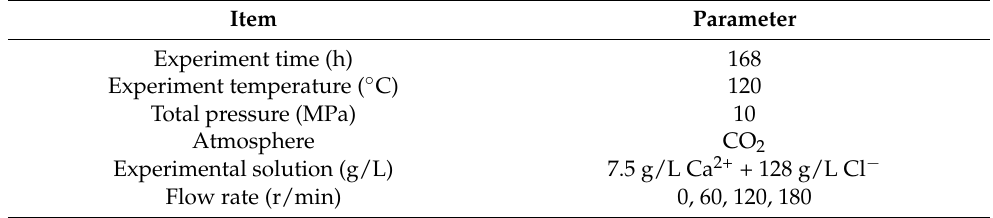
Figure 2. The schematic diagram of high-temperature and high-pressure autoclaves and specimen holder: ( a ) high-temperature and high-pressure autoclaves; ( b ) specimen holder.